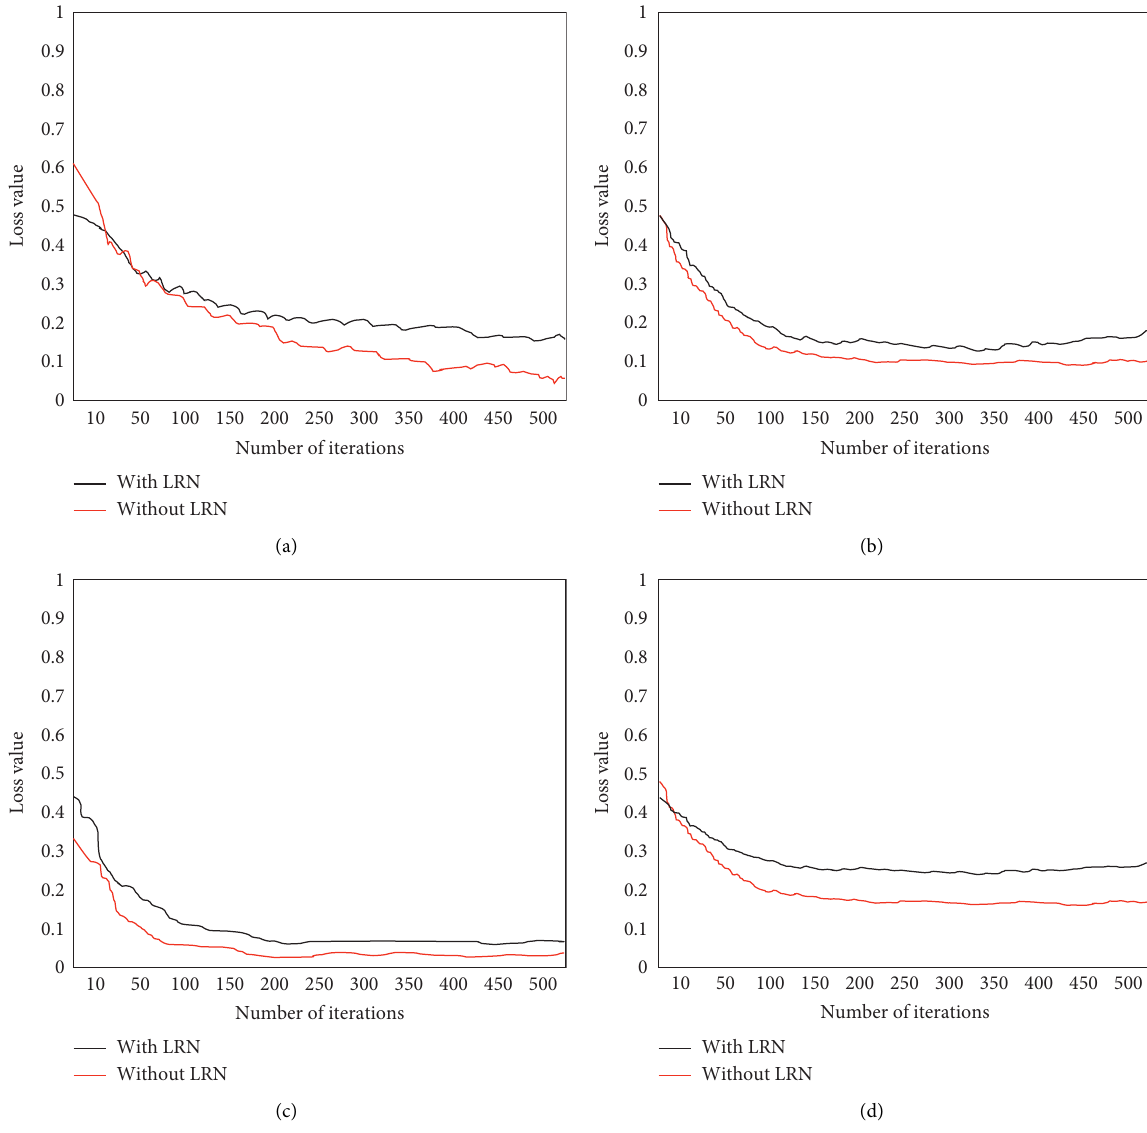
Figure 4: The change curve of the loss function of the training sample and the test sample with the number of iterations. (a) Loss value with training in HMDB51 dataset. (b) Loss value with training in UCF-101 dataset. (c) Loss value with testing in HMDB51 dataset. (d) Loss value with testing in UCF-101